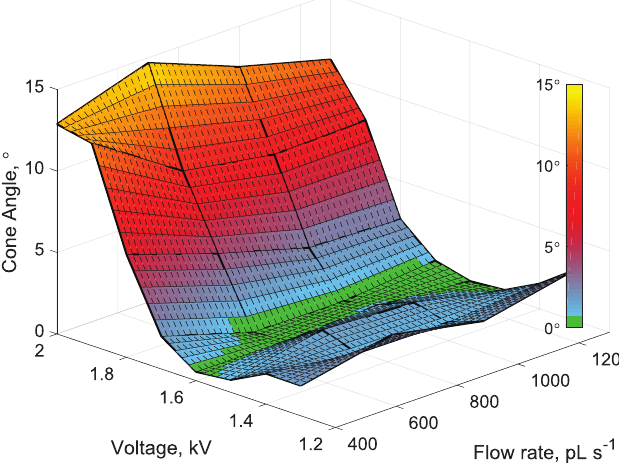
Figure 4. Parameter map of cone-jet tilt angle with respect to the center axis, θ c , for an EMI-Im electrospray. No unsteady EHD modes were observed over the entire flow-voltage map. Instead, skewed cone-jet mode was observed over the range of voltages, with steady cone-jet residing from 1.5kV to 1.7kV. Figure modified from Ref.